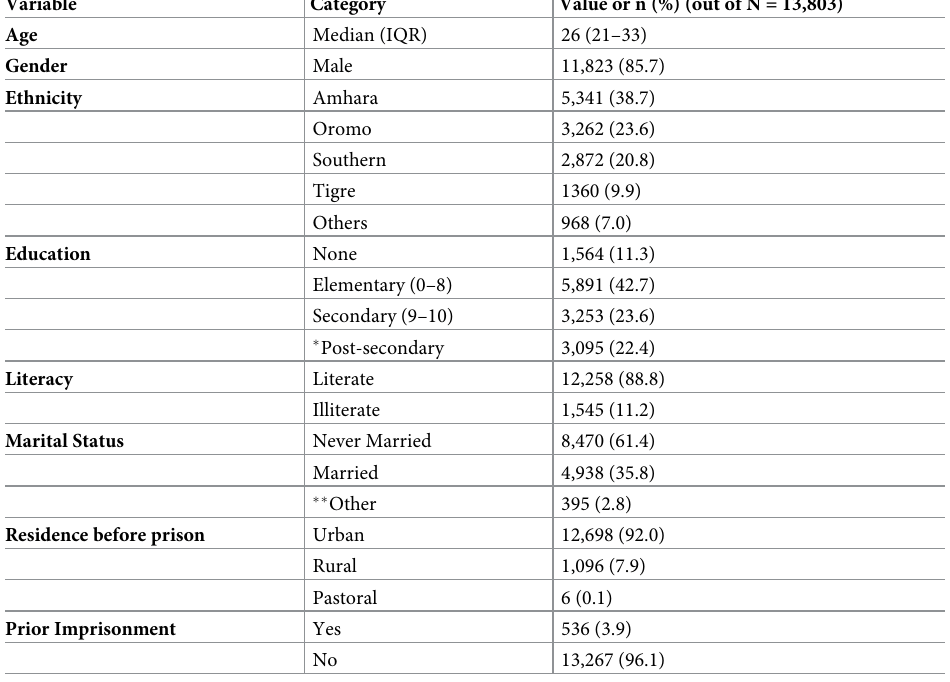
Table 1. Socio-demographic characteristics of 13,803 study